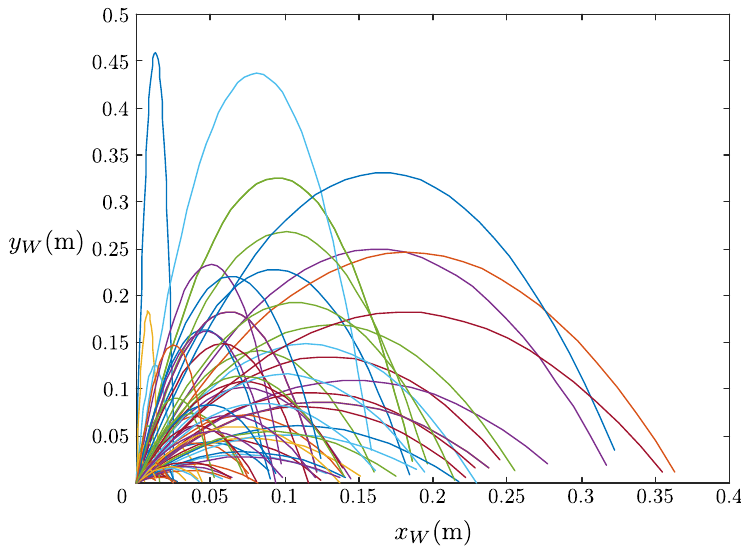
Figure 13. The training data sets.